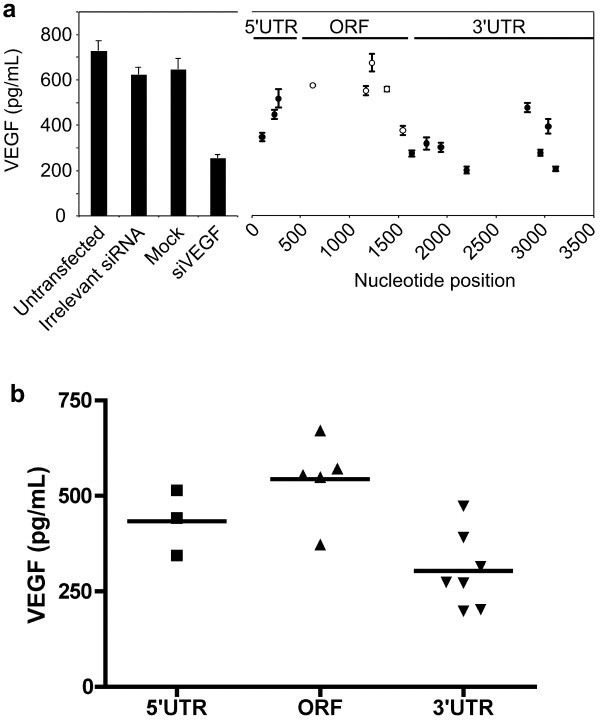
Analysis of target site selection. (a) VEGF-A suppression by 21 nt RNA duplexes (with central mismatches) targeting different regions of the VEGF-A mRNA. ARPE-19 cells were transfected with 40 nM indicated RNA duplexes. VEGF-A in cell culture supernatant was measured by ELISA 48 hours post-transfection and 24 hours post-stimulation with 130 μM Deferoxamine. Each point represents the mean of triplicate samples. Error bars indicate standard deviation. (b) Statistical analysis of data for VEGF-A suppression depicted in Panel (a). There was a significant difference (p < 0.05) between the means for molecules targeting the 3'UTR as compared to molecules targeting the ORF as determined by one-way ANOVA with a Bonferroni post-test.